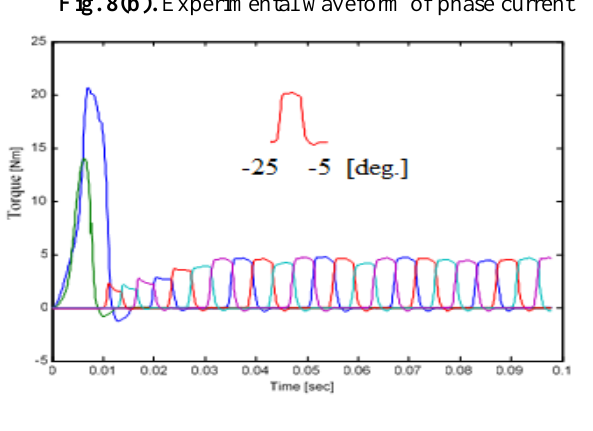
Fig. 9. Phase torque waveform of 4-phase machine excluding the control